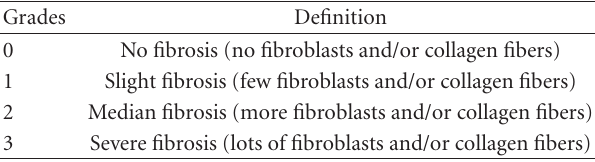
Table 2: Definitions of microscopic fibrosis grading system [11].